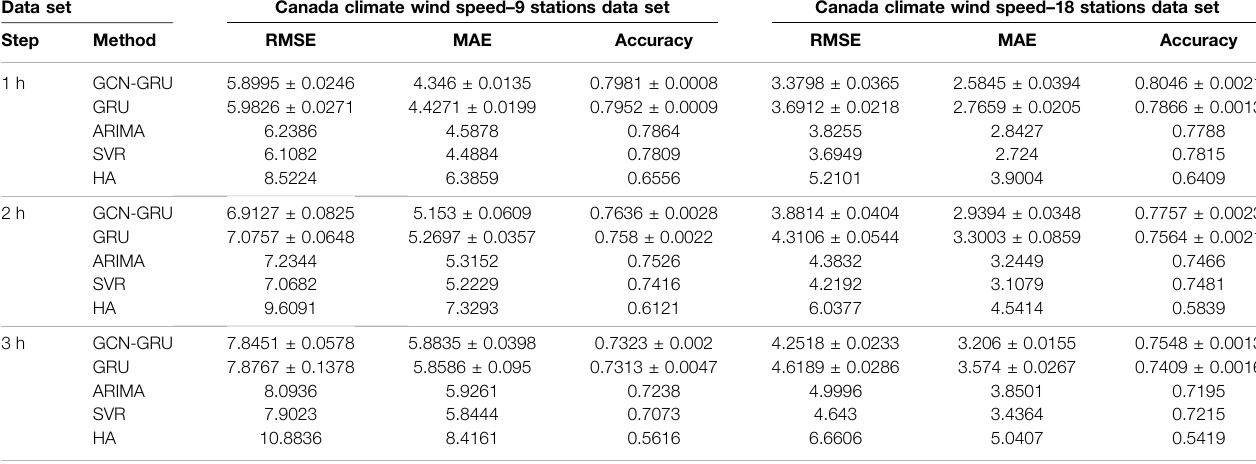
TABLE 1 | The best results in Canada climate wind speed experiments. Data set